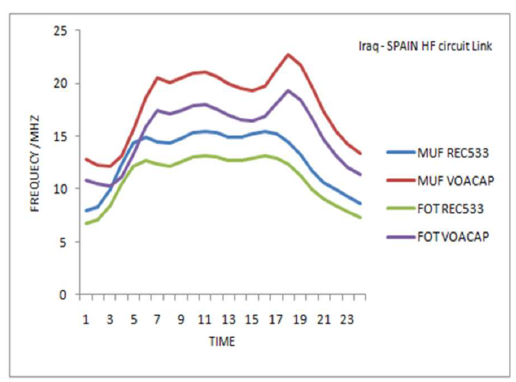
Fig. 13. Shows Iraq- Kazakhstan HF circuit link prediction.